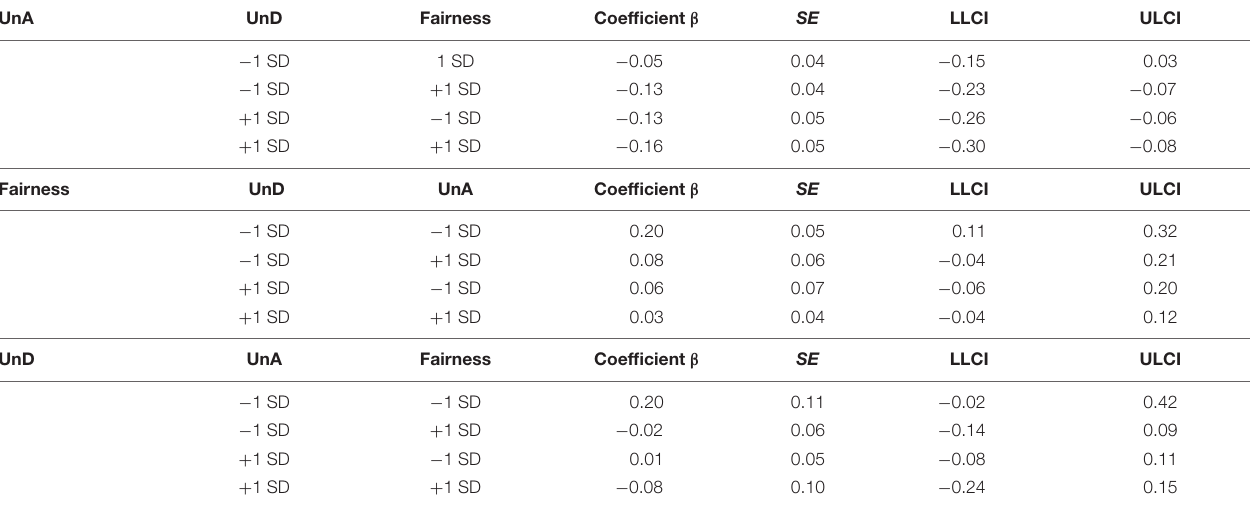
TABLE 7 | Trust mediating the conditional indirect effects of X (UnA, Fairness, UnD) on Y (Cooperation Intention) at values of the variables (Hayes, 2013, Model 11). UnA